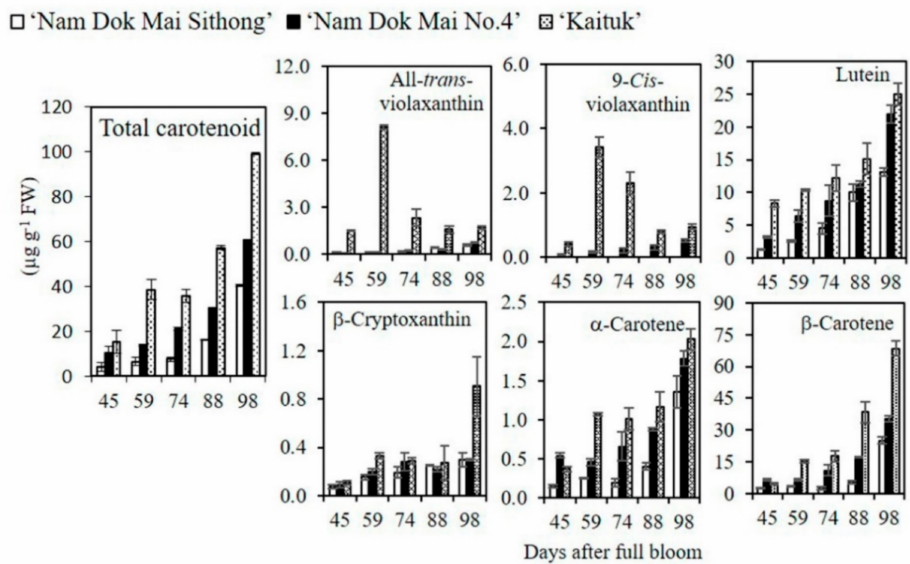
Figure 6. Changes in carotenoid content and compositions in pulp of mango fruit cv. ‘Nam Dok Mai Sithong’, ‘Nam Dok Mai No. 4’ and ‘Kaituk’ during fruit development (45-88 days) and full ripening stage (98 days). The vertical bars represent the means with SE for three